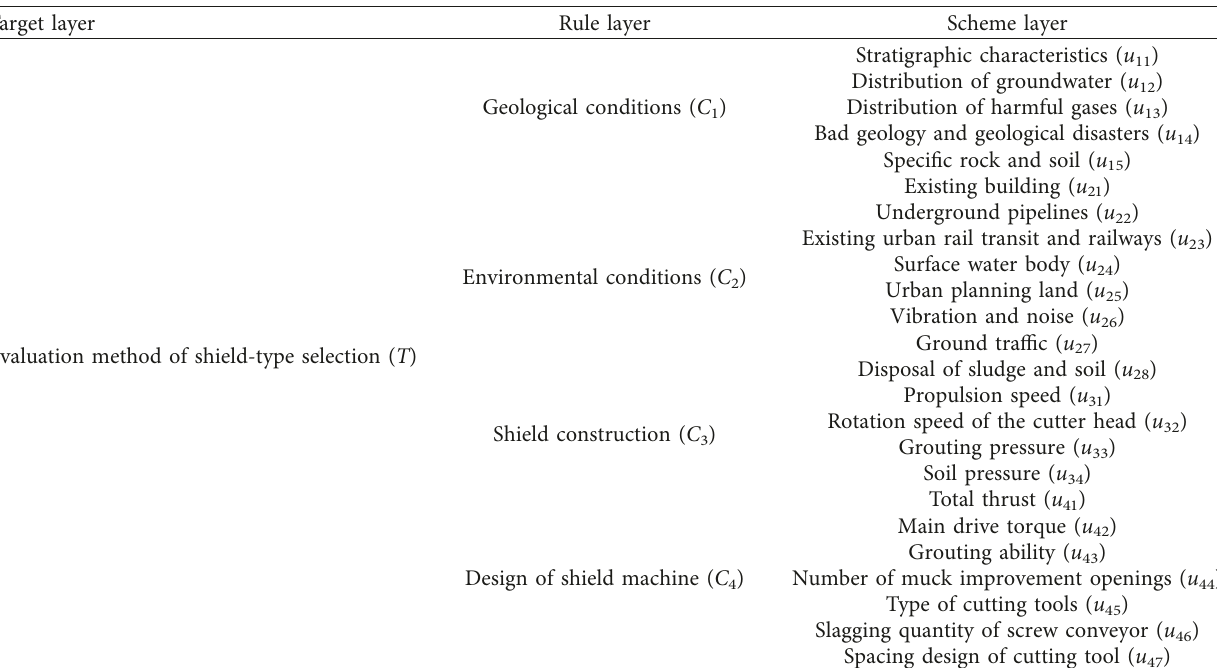
Table 3: Primary evaluation indices.